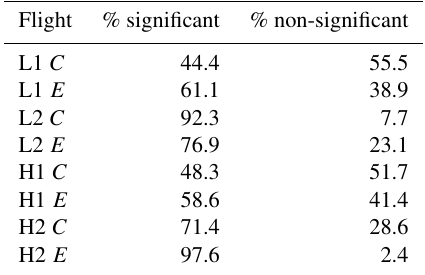
Table 6. Percentage of inhomogeneities that are significant and non- significant (as compared to a randomly distributed droplet